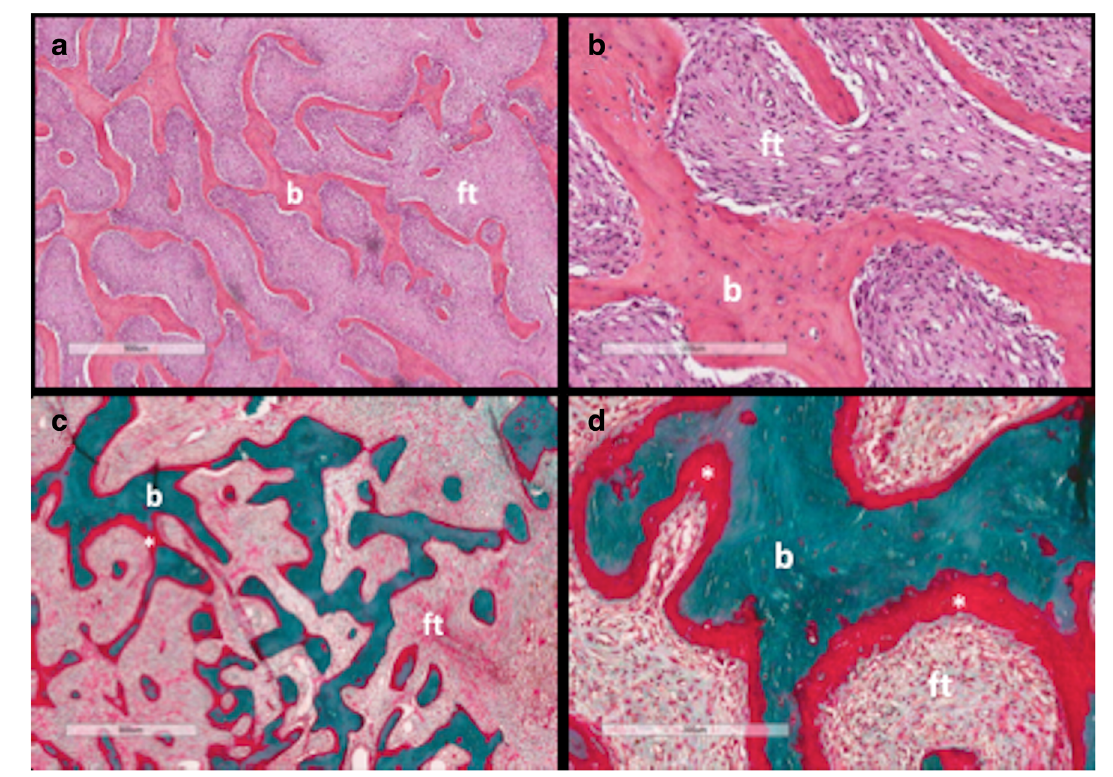
Fig. 3 Histopathological features of fibrous dysplasia (FD). FD lesions are composed offibrous tissue interspersed between bone trabeculae. The amount ofbone within lesions is quite variable. Trabeculae are dysplastic, non-stress oriented, and appear disorganised. Haematoxylin-eosin stained sections in low ( a ) and high power ( b ) show irregular, discontinuous